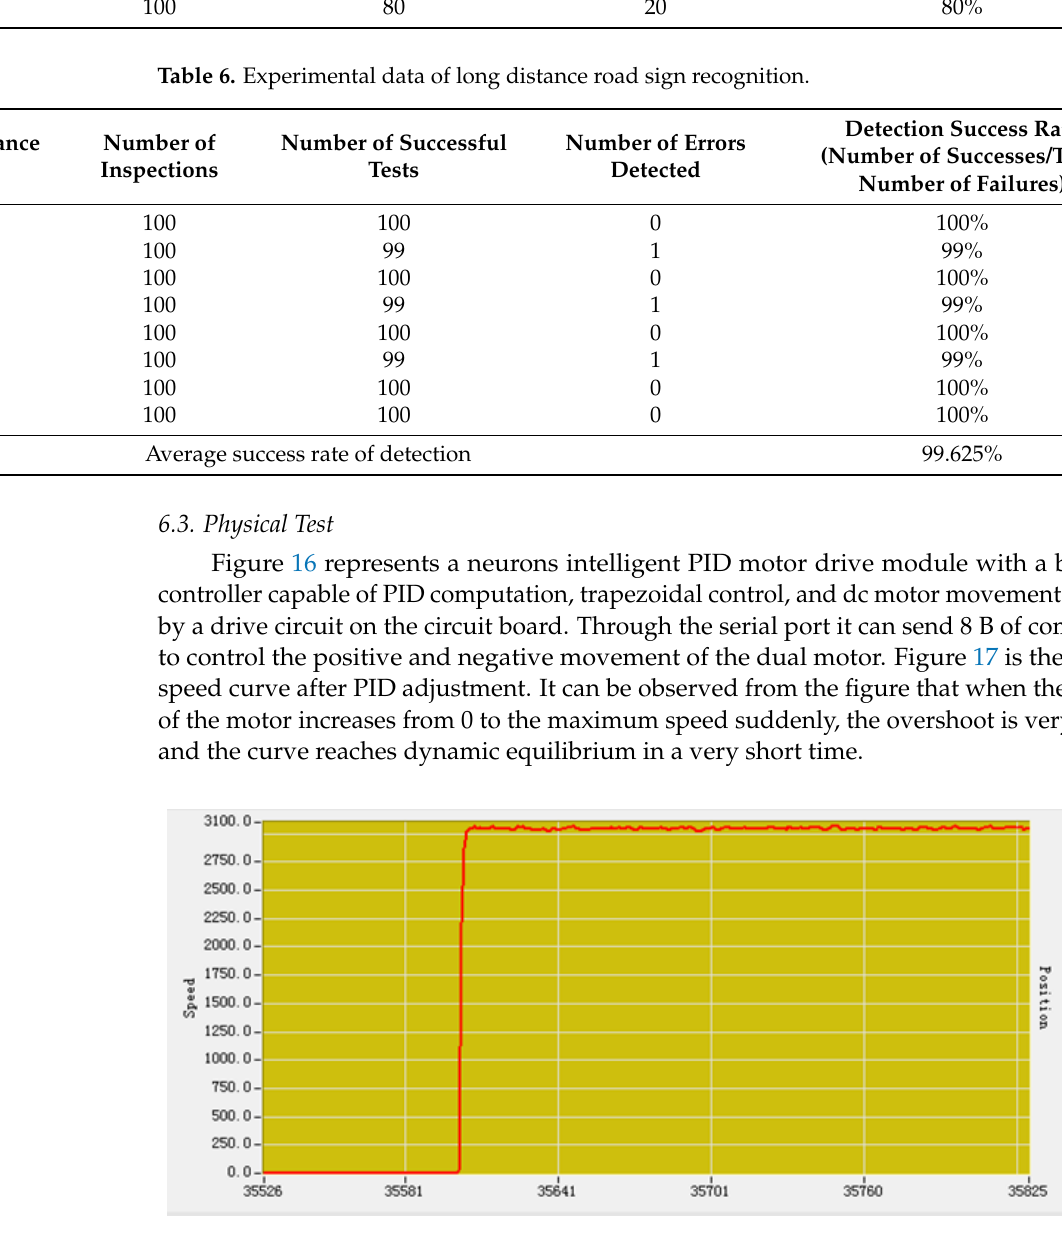
Figure 17. Motor speed curve.